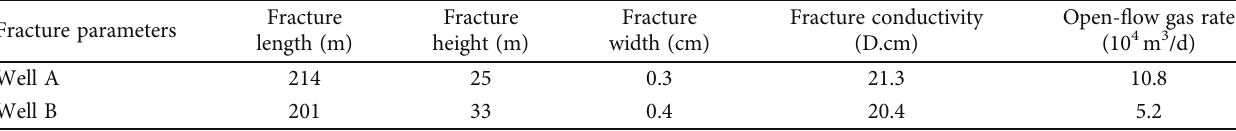
Table 7: Hydraulic fracture parameters for wells A and B in the Daniudi gas reservoir